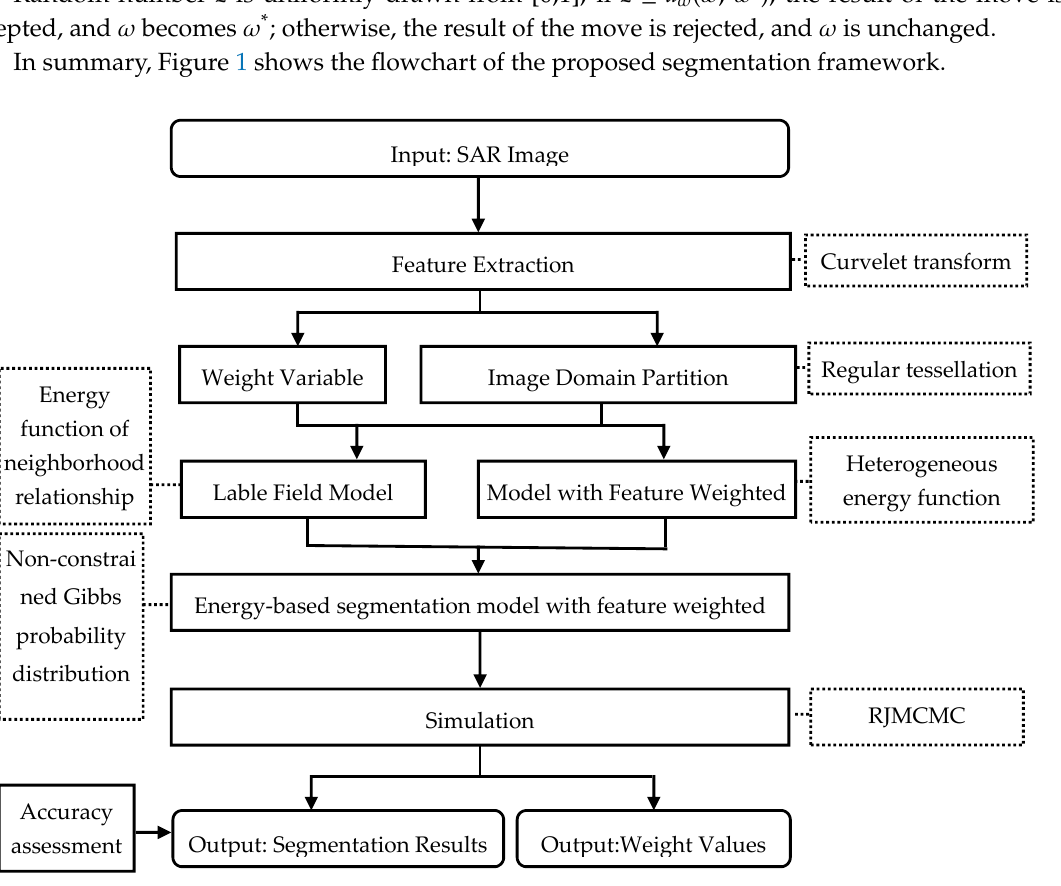
Figure 1. Flowchart of the proposed segmentation framework.